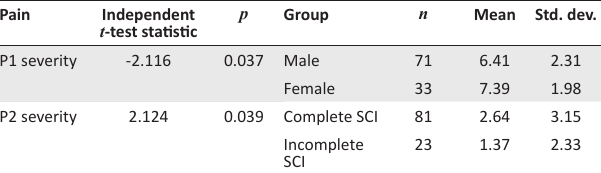
SCI, spinal cord injury; Std. dev., standard deviation.